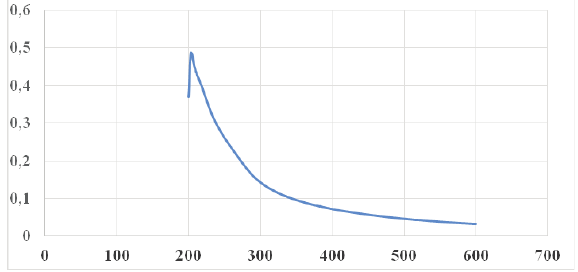
(WO ) nano-particles 2 4 3